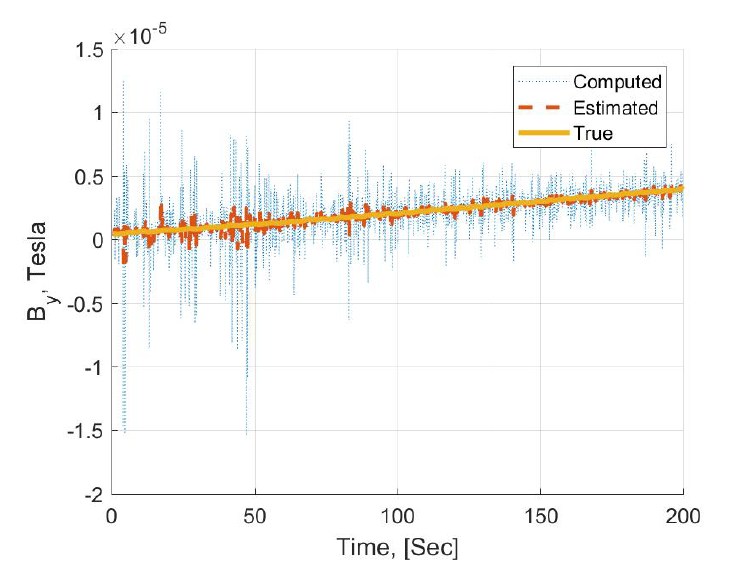
Figure 18. Magnetic field history in the Y direction for 1st maneuver.